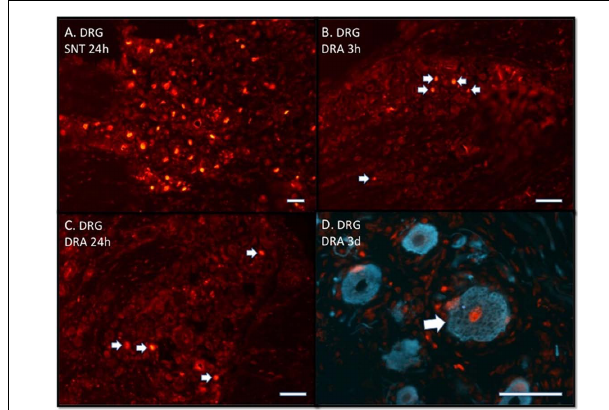
FIGURE 1 | (A–D) Immunofluorescence photomicrographs stained with ATF3 antibodies showing dorsal root ganglia (DRG) after sciatic nerve transection (SNT) or dorsal root avulsion (DRA). Note that ATF3 labeling is localized in the nuclei. (A) Shows that the majority of the neurons are labeled 24h post-operatively. (B) Shows a few labeled neurons (arrows) already after 3h. (C) Shows that at 24h there are still only a few labeled neurons (arrows). (D) Shows a labeled (arrow) human DRG neuron three days after a traumatic DRA. (D) Double labeled with neurofilament antibodies. Scale bars 50 μ m (A–D) .